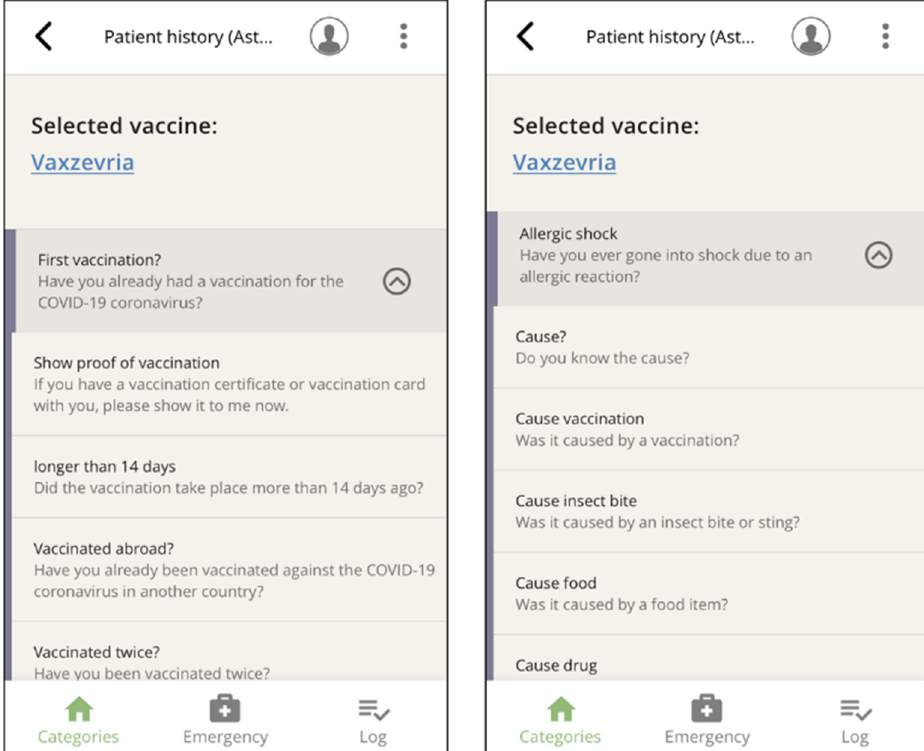
Figure 6. Two examples of filter questions that trigger related questions.